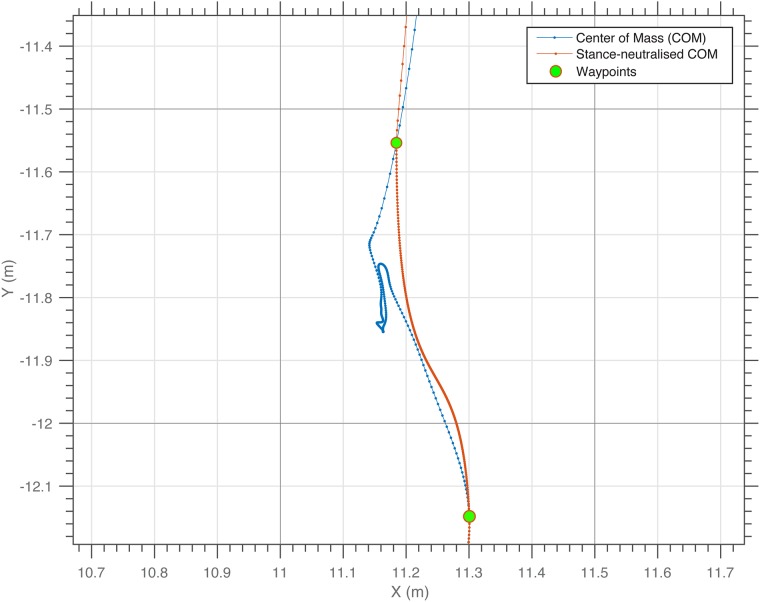
Stance-neutralization with waypoint method.The blue trajectory represents the actual horizontal movement of the center of mass (COM). In the example shown, the athlete moves from south to north and briefly stops in the center. Even if the athlete is standing still (both feet on the ground for a certain time), the COM trajectory would lead to artificial accumulating distances that are measured. The waypoint method (red trajectory) suppresses the micro movements that are not relevant for the gross motion.